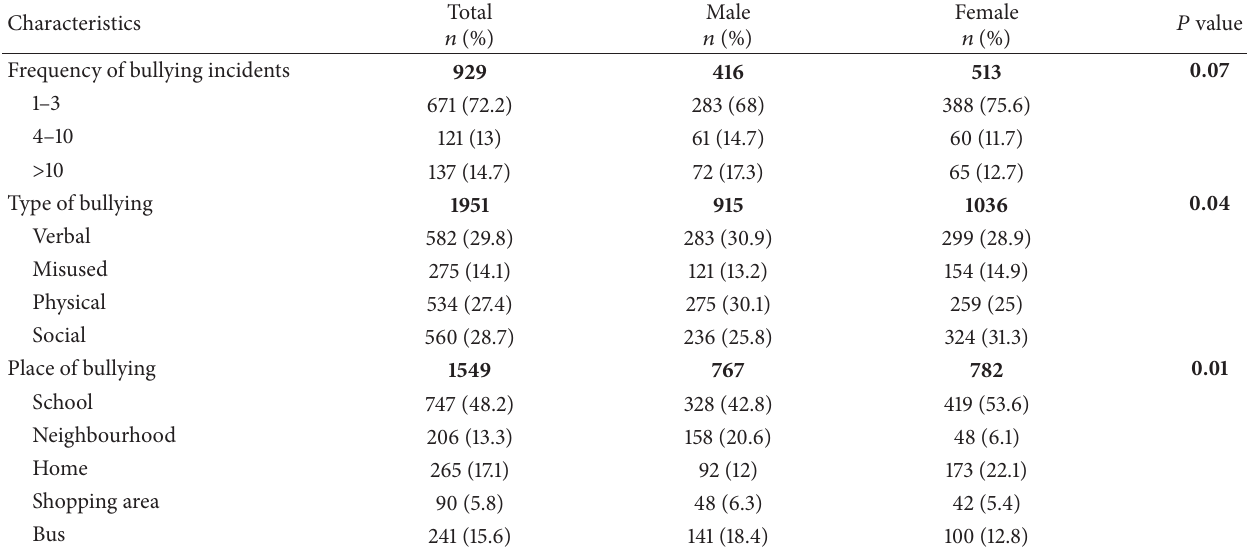
Table 2: Characteristics of bullying incidents among school pupils in a 12-month period stratified by gender, Oman, 2007.